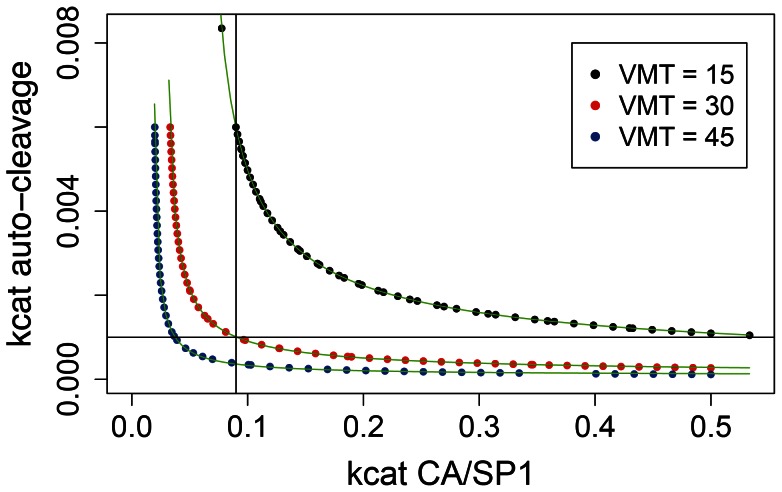
Isoclines of virion maturation time (VMT).The isoclines are drawn in the plane of the two rate parameters with the strongest effect on VMT. Generic hyperbola-like functions of the form y = a+b/(x−c)d could be fitted to the data. For VMT = 15 min: a = 10−4, b = 5×10−4, c = 0.058, d = 0.69; for VMT = 30 min: a = 10−4, b = 10−4, c = 0.027, d = 0.79; for VMT = 45 min: a = 9×10−5, b = 2×10−5, c = 0.017, d = 0.93; dimensions for parameters a–c and for both axes of the figure are s−1. The perpendicular lines indicate the default values of both parameters.